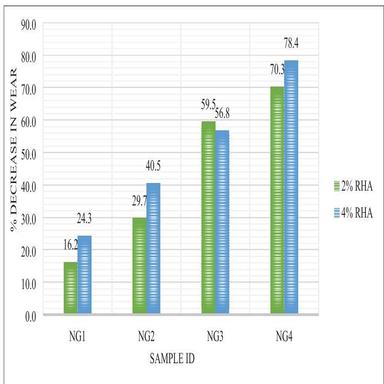
Variation in wear rate with respect to the addition of rice husk ash (300 rpm).